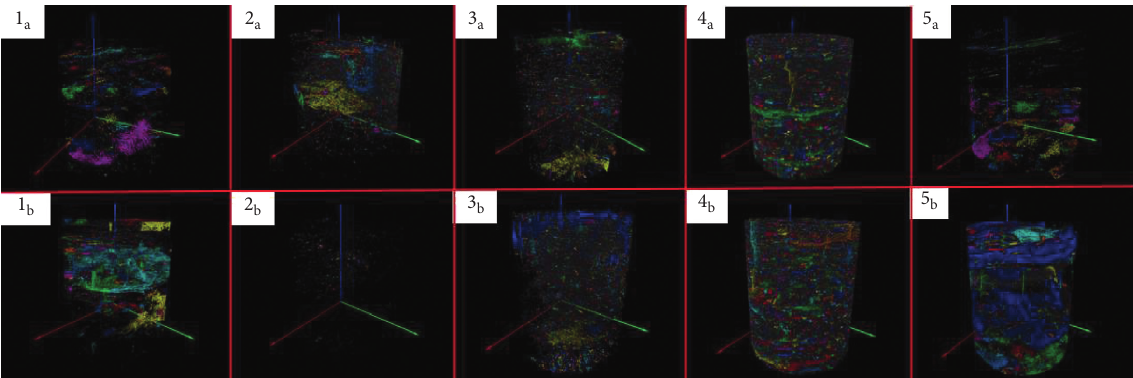
Figure 4: Internal fracture structure of the coal